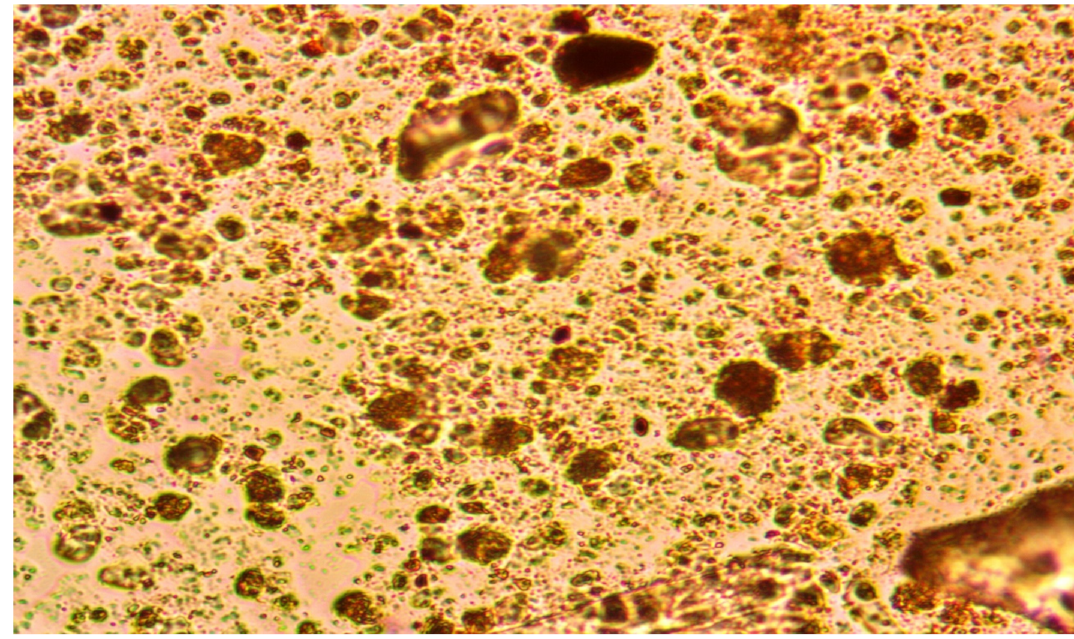
Figure 4. Catalyst, transmitted light, field of view = 0.5 mm. Particles are quartz grains coated in n − FeO x H y